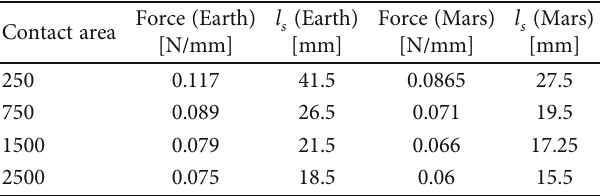
Figure 7: Bottom view of one HP 3 fl ight-model foot. Table 4: Results of the numerical analysis of single cleats with unit- width of Bekkers spaced-link track for Earth and Mars gravity.